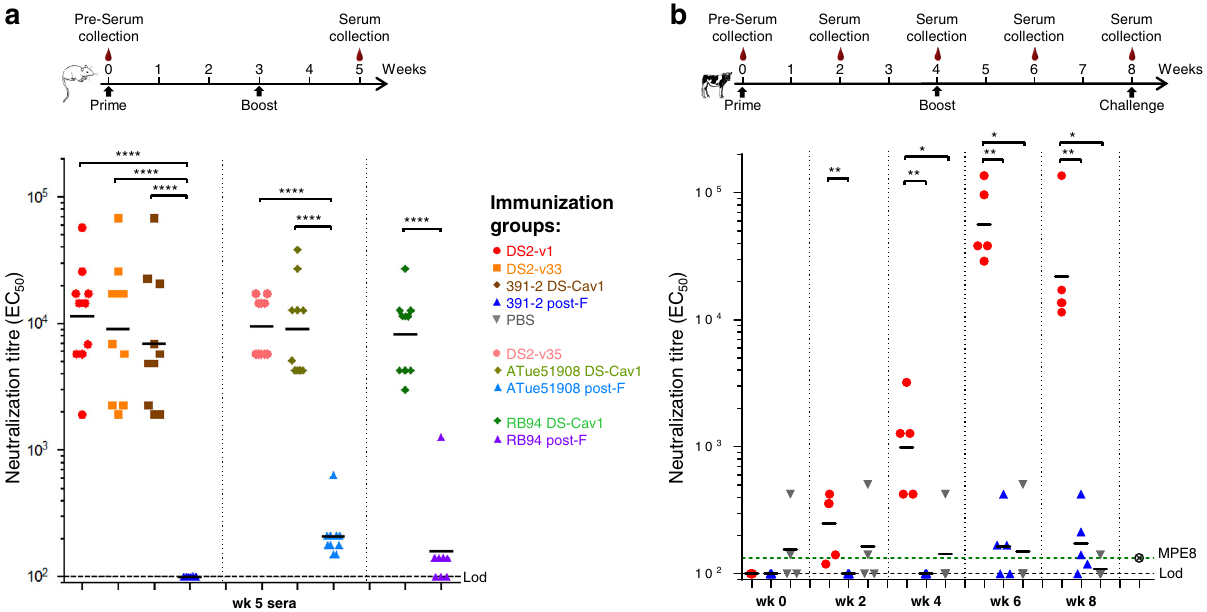
Fig. 3 Serum neutralizing antibody titers elicited by engineered bRSV F pre-F trimers. Pre-F-stabilized bRSV F glycoproteins elicited geometric mean EC 50 neutralization titers between 43 – 344-fold higher than post-F in mice and calves, respectively. Schematic immunization procedures for bRSV F variants in seronegative mice ( a ) and calves ( b ). Neutralization titer from each animal is shown as an individual dot , and geometric means are indicated by black horizontal lines . Immunization groups are color-coded. Lod, limit of detection (titer = 100) is indicated with a horizontal dashed line . Vertical dotted lines separate immunogen strains in a and weeks post prime in b . Serum antibody binding ELISA data is summarized in Supplementary Fig. 3. P values were determined by two-tailed Mann – Whitney tests. *Indicates P ≤ 0.05, **indicates P ≤ 0.01, ***indicates P ≤ 0.001 and ****indicates P ≤ 0.0001. There are 10 mice per group for the mouse immunizations. For calf immunizations, the DS2-v1 and post-F groups each contained fi ve animals and the placebo group contained four